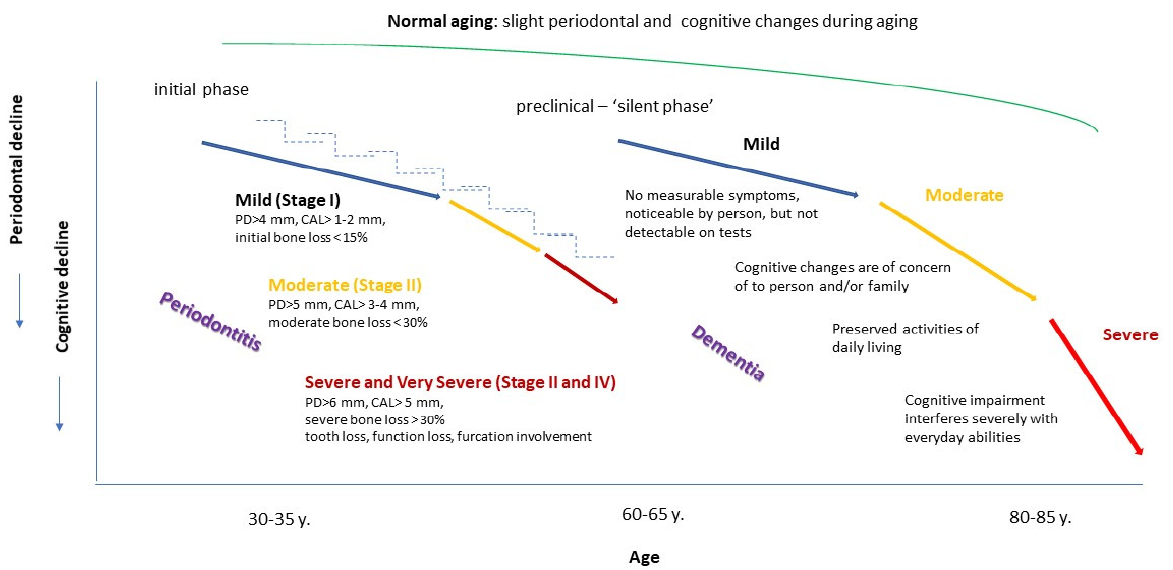
Figure 1. The timeline continuum of periodontitis versus age-related cognitive impairment. The aging process unequally confounds the time available for periodontitis and age-related cognitive impairment initiation over a lifespan.